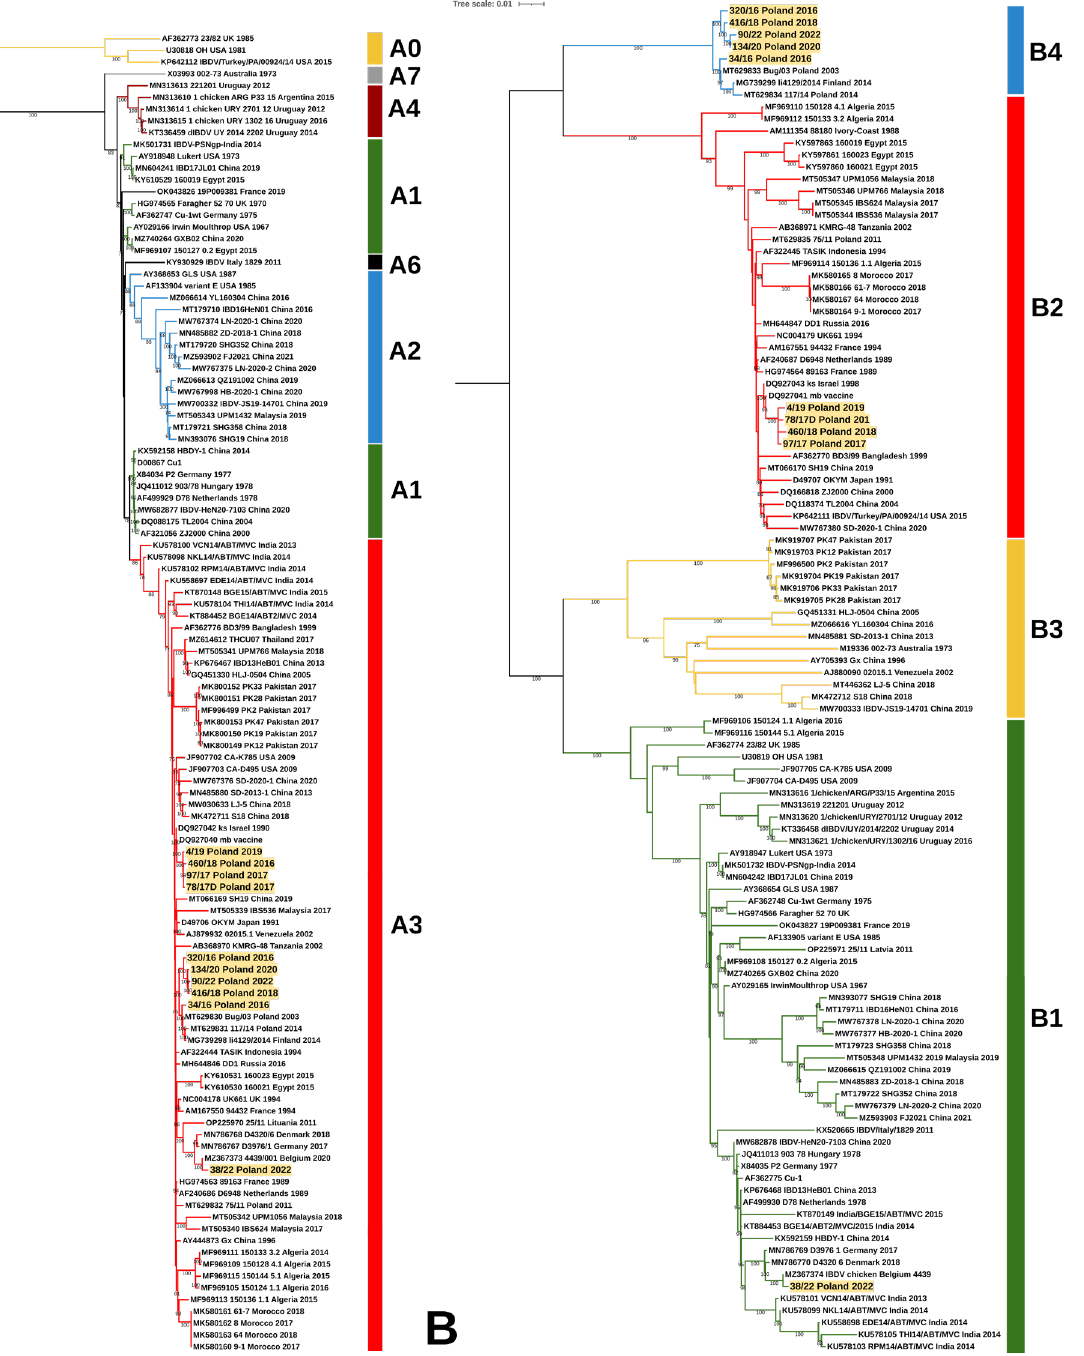
Figure 6. Maximum likelihood phylogenetic analysis of full coding sequence of ( A ) segment A (3076 nt) and (B) B (2640 nt). Trees were constructed using GTR+F+I+G4 with 1000 bootstrap iterations. The main IBDV genogroups are denoted with designation and colors, and the taxa name of the Polish strains characterized in the presented study are highlighted with yellow.